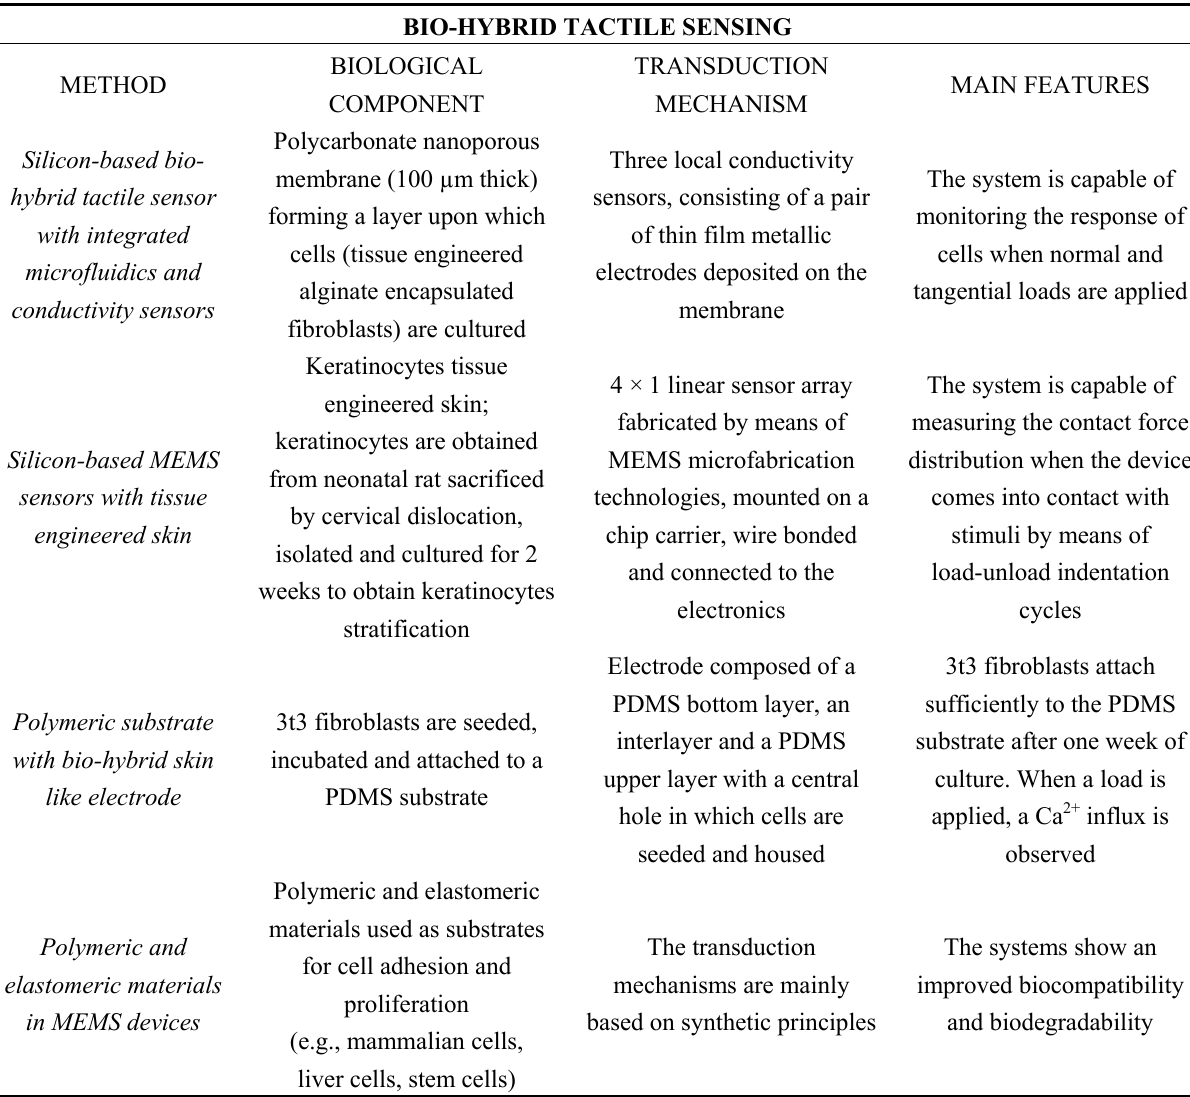
Table 3. Bio-hybrid tactile sensing: biological component, transduction mechanism and main